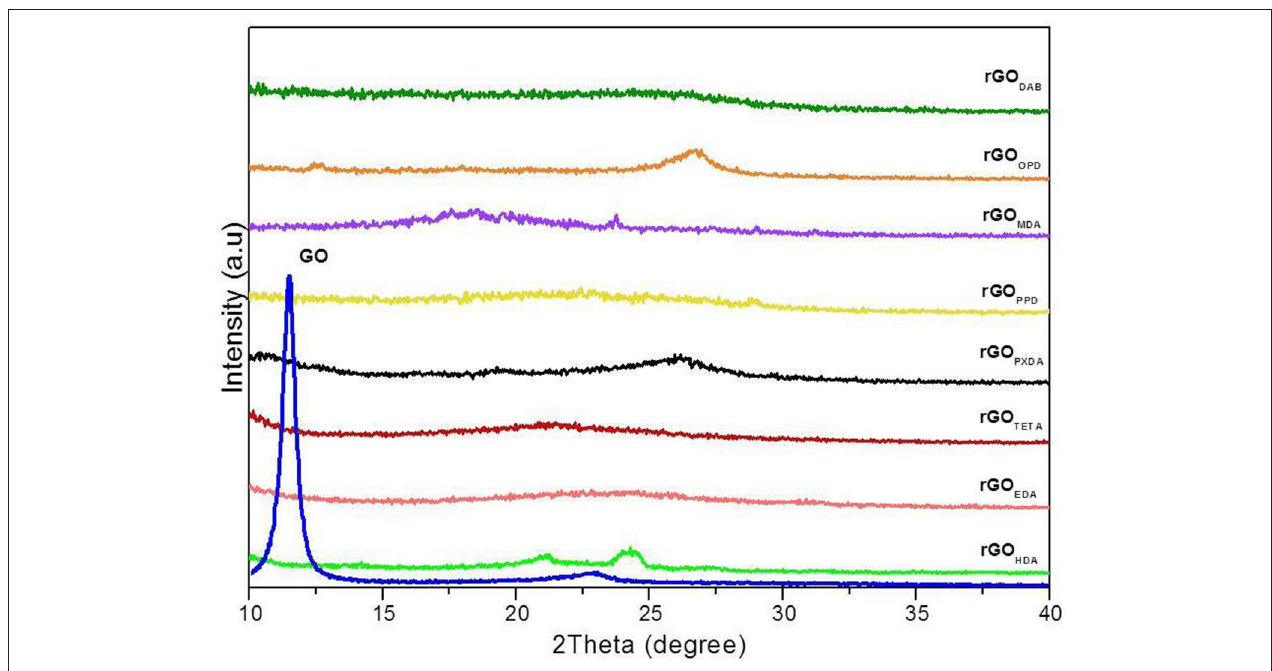
FIGURE 10 | XRD patterns of rGO aerogels and